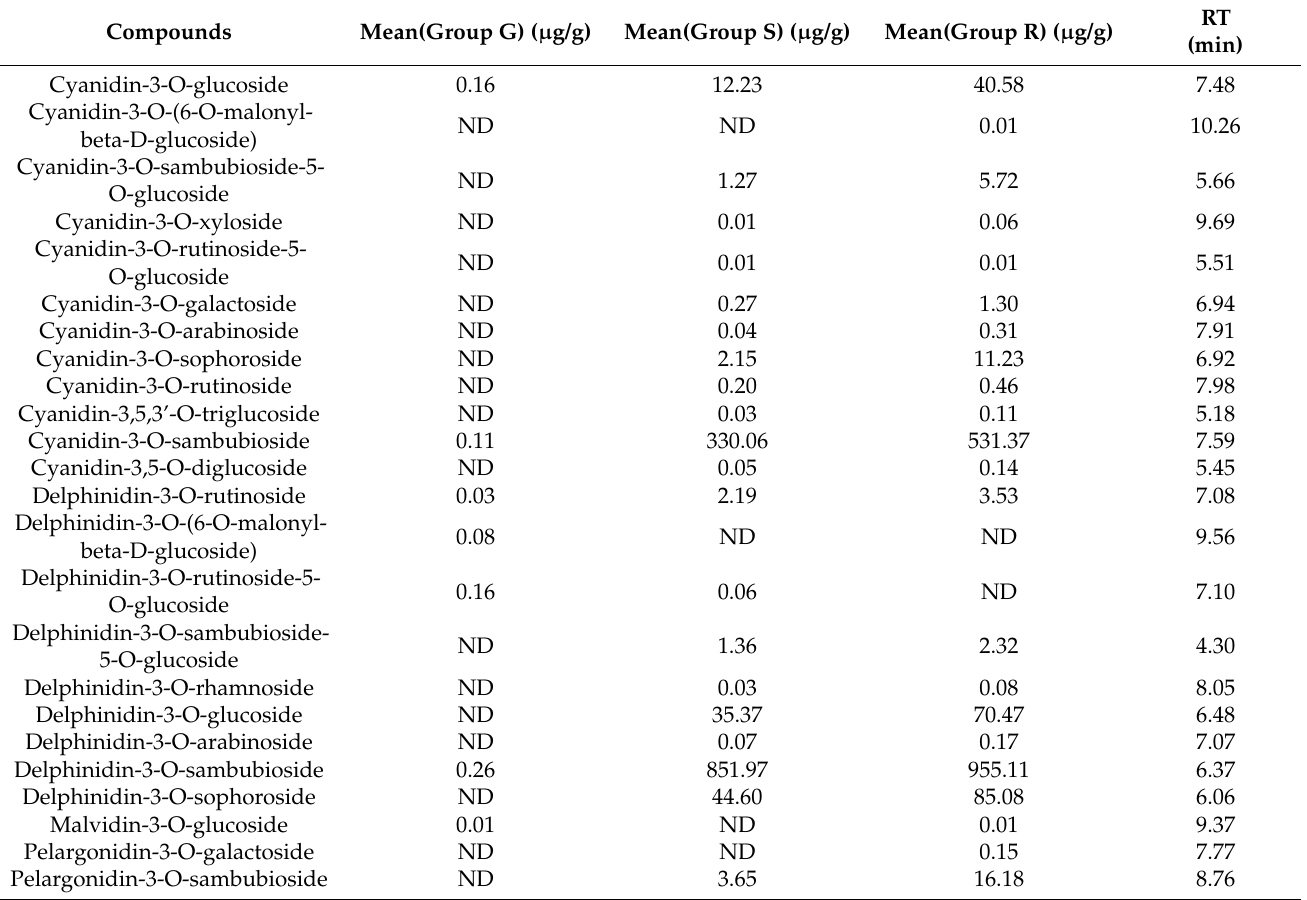
Table 1. Anthocyanin contents among different cultivars.